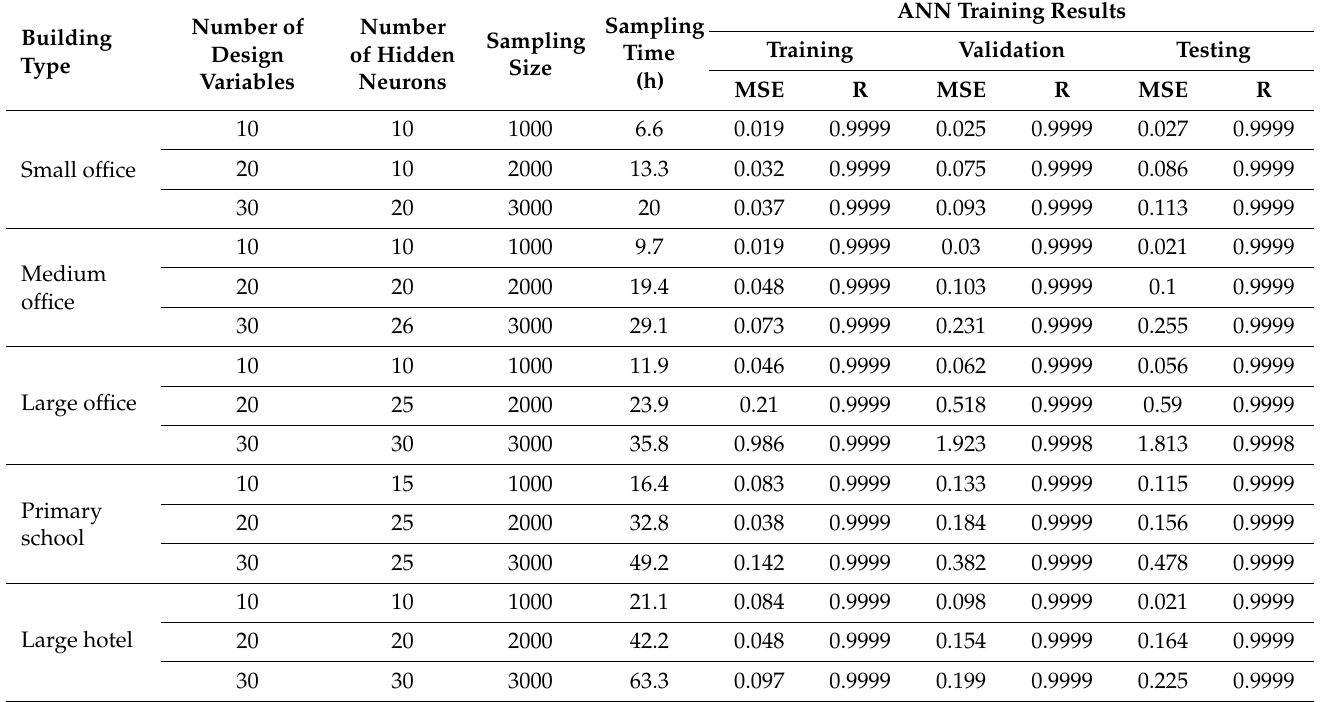
Table 3. ANN training and validation